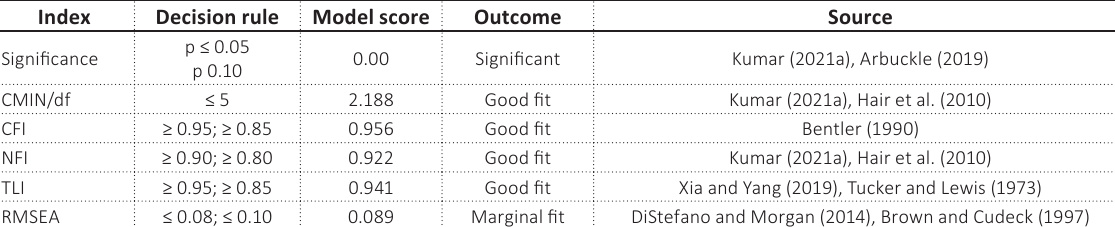
Table 3. The goodness of fit